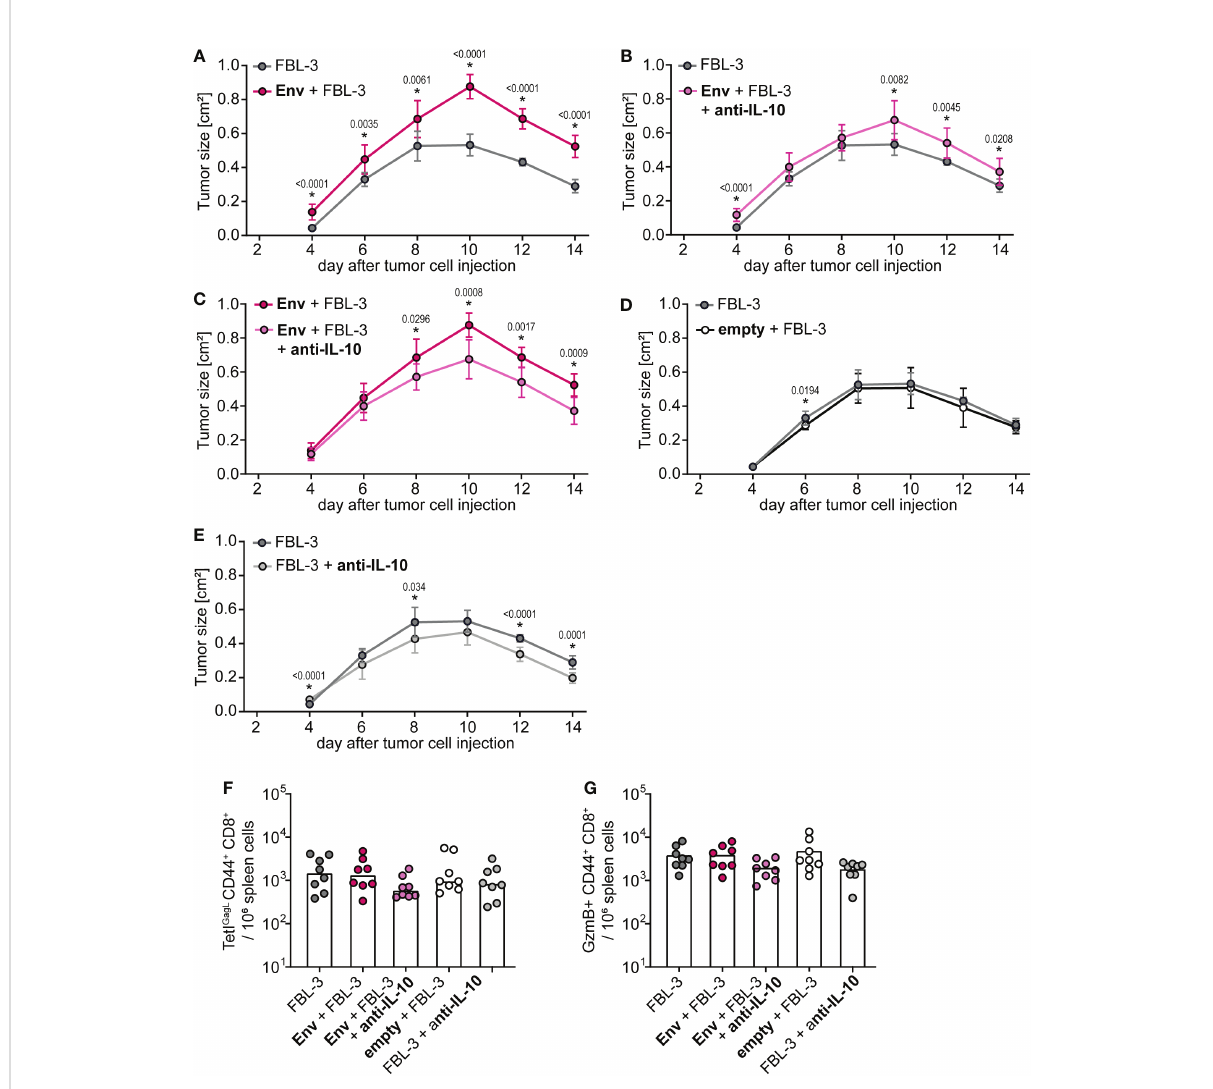
FIGURE 5 Control of tumor growth after F-MuLV Env immunization is restored by anti-IL-10 antibody treatment. (A – E) CB6F1 mice were inoculated with 5 × 10 6 FBL-3 cells by subcutaneous injection with or without an immunization with 25 µg of F-MuLV Env encoding plasmid pCG.env or an empty control plasmid 3 days before. Mice were treated with an anti-IL-10 antibody three times per week or left untreated, and tumor size was measured every other day. (F, G) Fourteen days after tumor cell injection, mice were sacri fi ced and the frequency of GagL 85-93 -speci fi c CD8 + T cells (F) and of granzyme B + CD8 + T cells in spleen cells was determined by fl ow cytometry (G). Data from eight mice per group were acquired in one experiment. (A – E) The mean tumor size with standard deviation. (F, G) Each dot indicates an individual mouse, and bars indicate median values. Statistically signi fi cant differences between the groups shown in the individual plots (A – E) at the same time point are indicated by * [ p